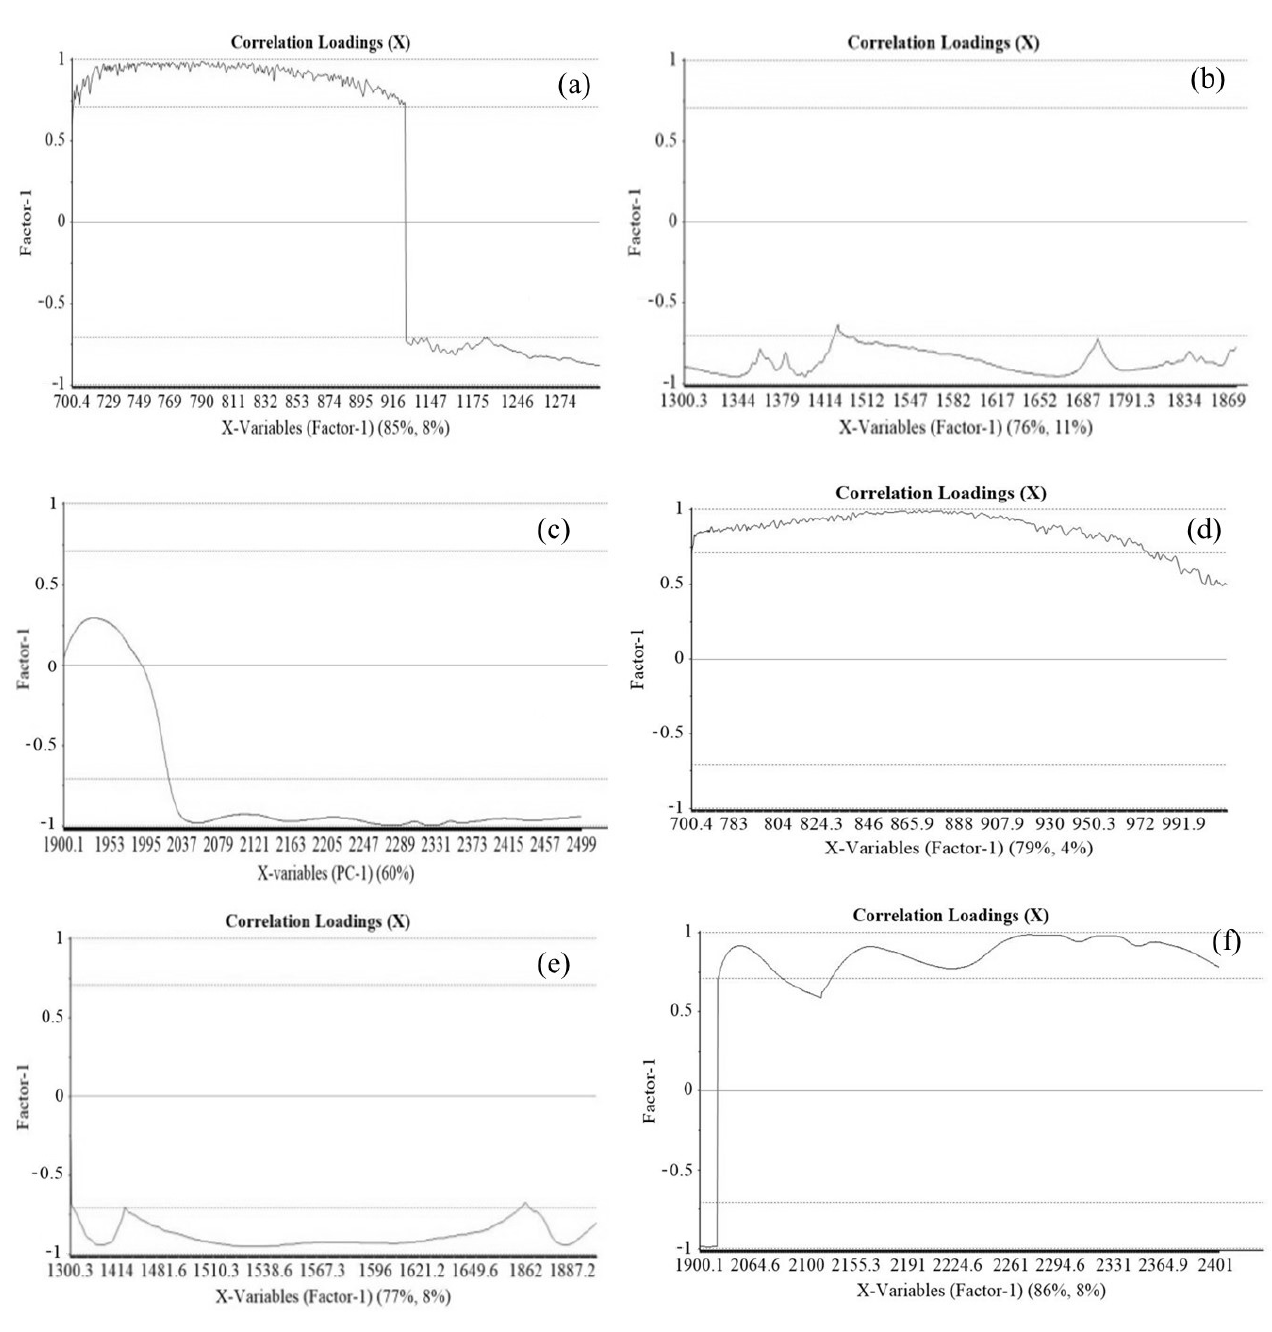
Figure 3. PLS loading plots in wavelength ranges ( a ) 700–1300 nm, ( b ) 1300–1900 nm, and ( c ) 1900–2500 nm for hulled oats and ( d ) 700–1300 nm, ( e ) 1300–1900 nm, and ( f ) 1900–2500 nm for naked oats.